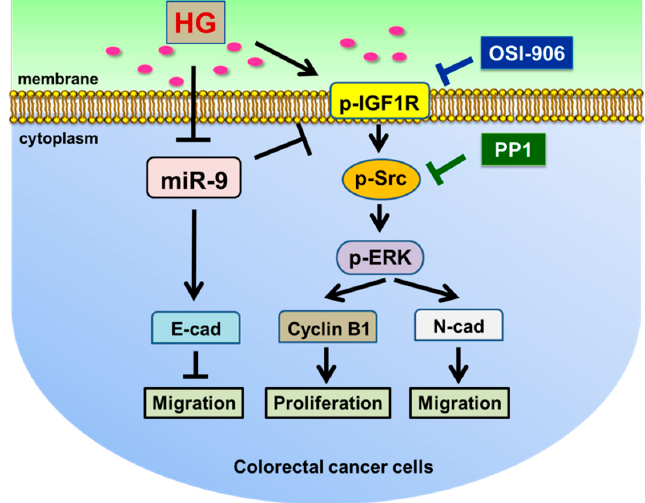
Figure 7. Molecular mechanism through which high glucose (HG) concentration promotes proliferation and migration in colorectal cancer (CRC) cells. HG concentration activated pIGF1R and p-Src expression and increased downstream signaling by mediating the downregulation of miR-9 expression. Moreover, OSI-906 decreased the expression of the EMT protein N-cadherin and reduced the expression of the cell-cycle-regulated protein cyclin B1, as determined through Western blotting, but only cyclin B1 and E-cadherin were unchanged in SW620 cells (Figure 3I). Similarly, PP1 decreased the expression of the EMT protein N-cadherin and reduced the expression of the cell-cycle-regulated protein cyclin B1, as determined through Western blotting (Figure 3J), compared with the control group (dimethyl sulfoxide) cultured in HG-concentration medium. These data demonstrate that HG concentration promoted CRC cell proliferation, modulated EMT protein expression and